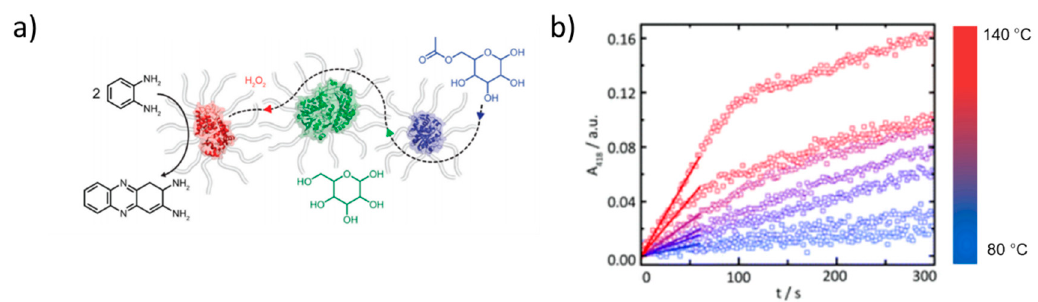
Figure 5. ( a ) Single enzyme nanoparticles from HRP (red), GOx (green), and lipase (blue) used for enzymatic cascades in the solvent-free phase. ( b ) Conversion of o-phenylenediamine to 2,3-diaminophenazine by HRP during the cascade reaction at temperatures > 80 °C in the absence of solvent. Adapted from Atkins et al. (doi:10.1039/c9nr06045f) as published by the Royal Society of Chemistry [128].